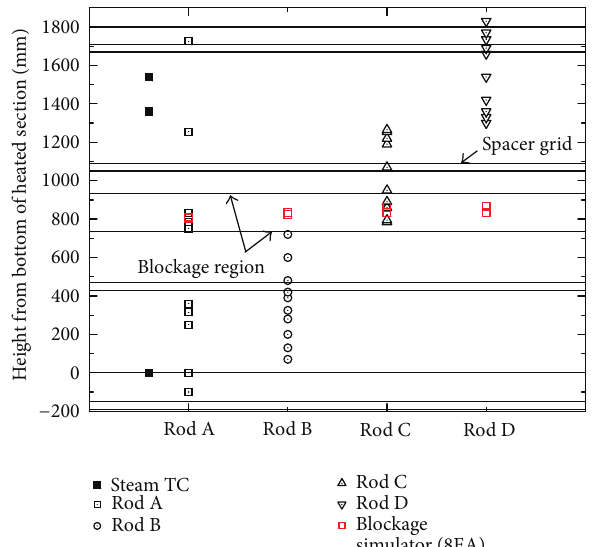
Figure 3: Axial TC locations of the test section.